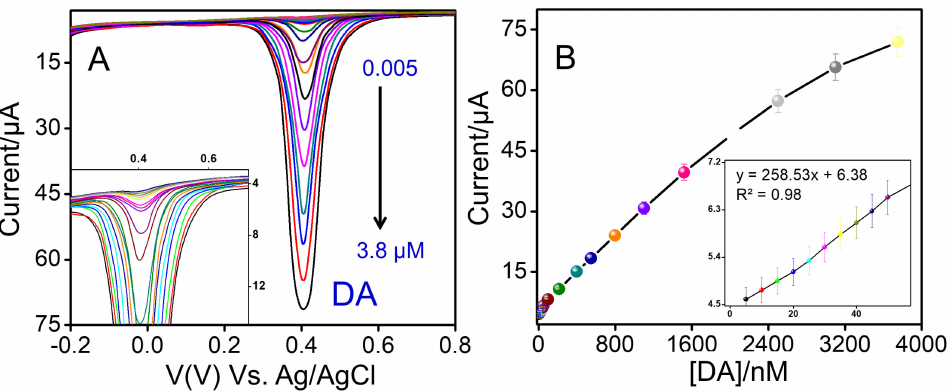
Figure 4. ( A ) DPVs of SNPO-CPL-800 toward increasing concentration of DA in 0.1 M PBS (pH 7) electrolyte. ( B ) Calibration curves (current versus concentration) of DA derived from their respective DPV